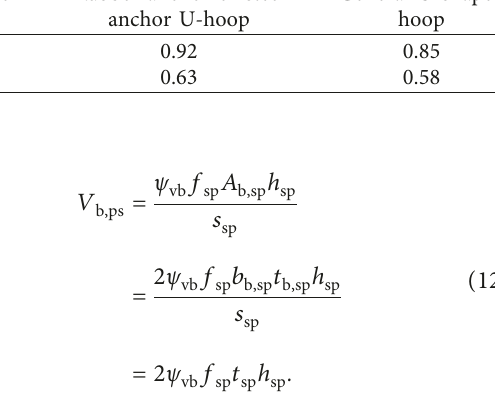
General U-shaped hoop